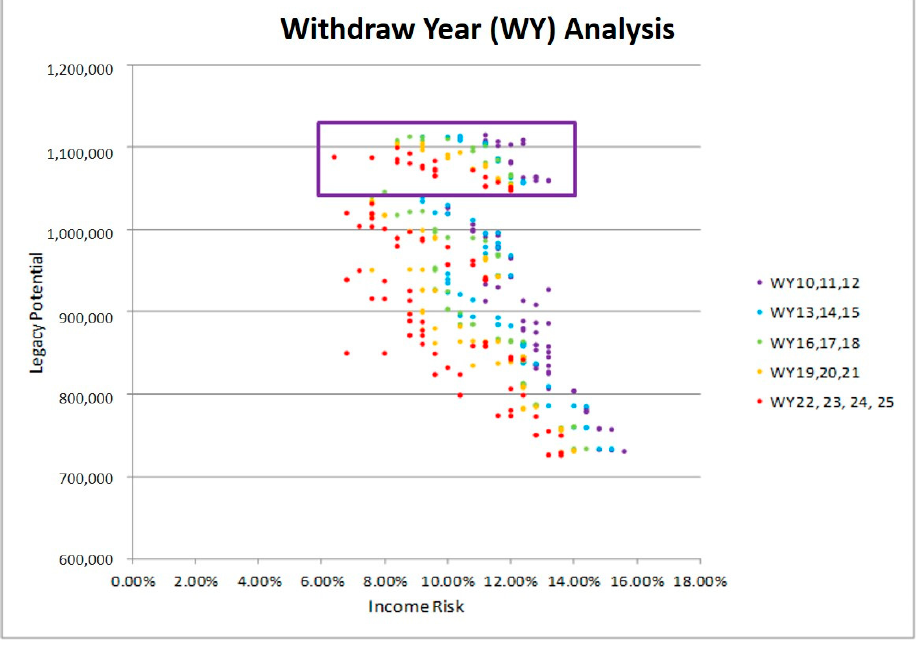
Figure 5. Analysis of withdrawal years.